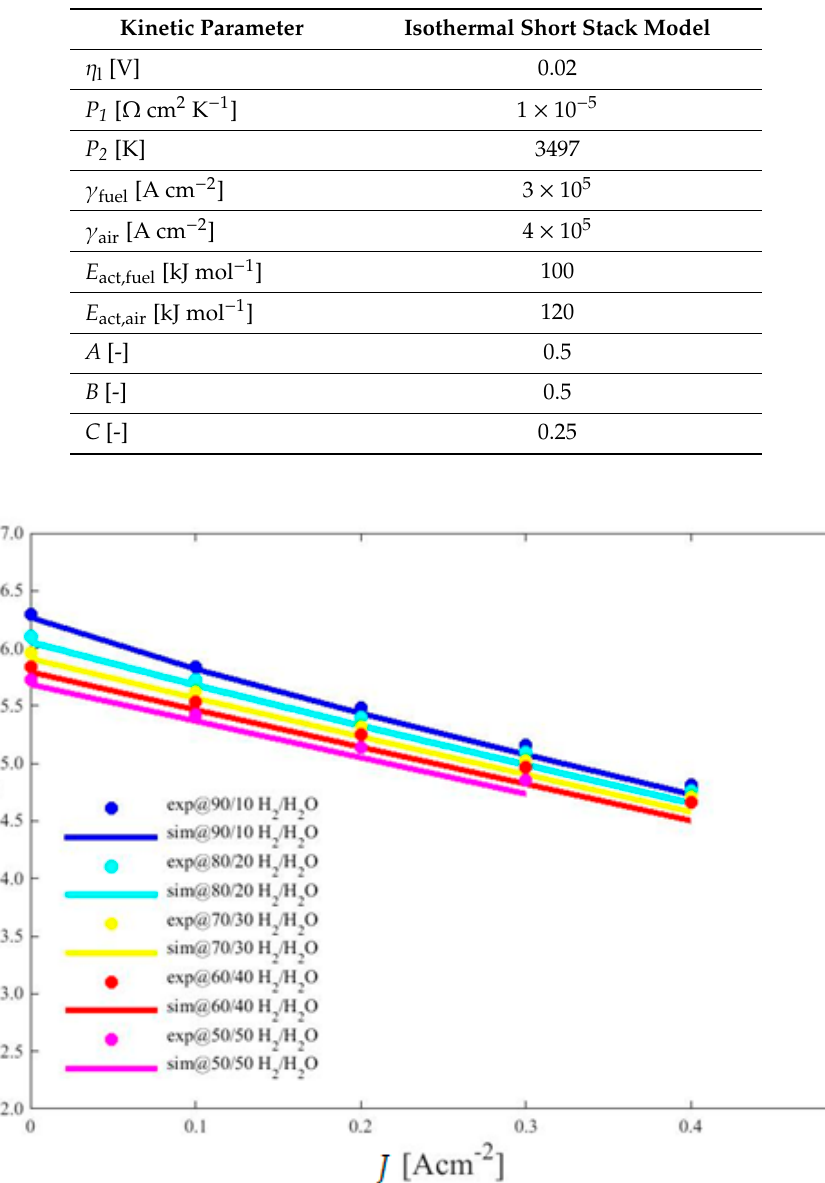
Figure 3. Polarization curves validation of a Solid Oxide Electrolyzer Cell (SOEC) short stack working at 1023 K though 2D isothermal modeling. After successful validation of the electrochemical kinetics at different feed compositions, the study has focused on the system thermal behavior to highlight the temperature increase or decrease